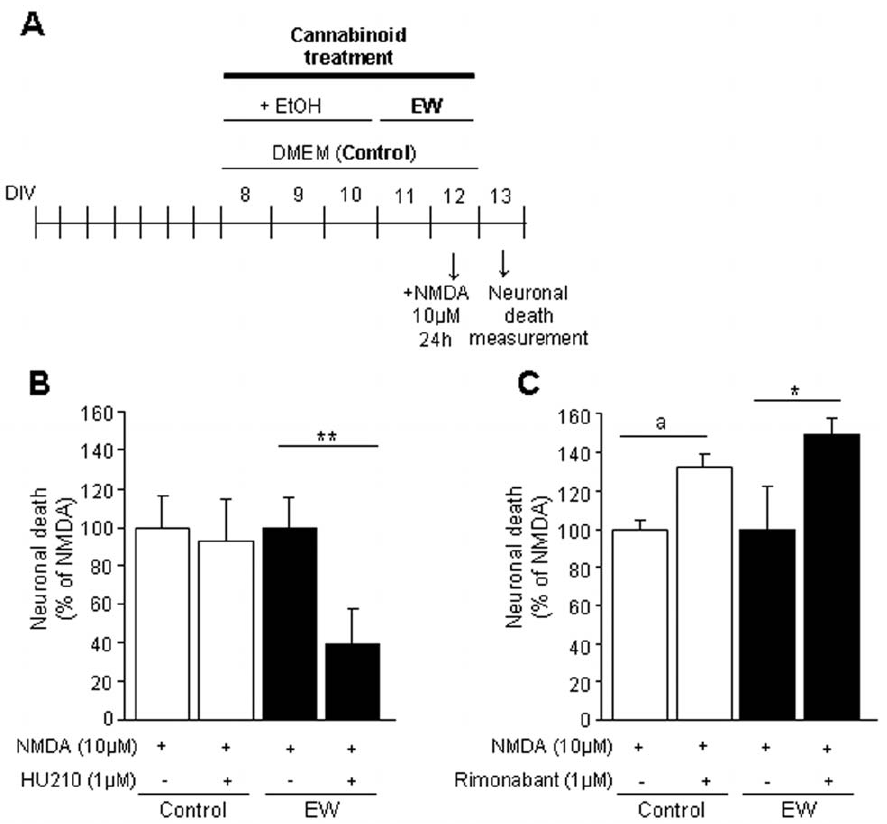
Figure 4. The chronic manipulation of the endocannabinoid system influences neuronal viability during ethanol withdrawal. Effects of the chronic activation or blockade of the endocannabinoid signaling on neuronal viability in control (neurons not exposed to ethanol) or ethanol– withdrawn neurons (EW). (A) Representative scheme of the experimental protocol. (B) The chronic administration of the non-specific cannabinoid agonist HU-210 (1 m M) decreases NMDA-induced neuronal death during ethanol withdrawal. The neuroprotective effect of HU-210 is specific of ethanol withdrawal situation, since it has no effect on the control condition. (C) The chronic administration of the CB1 antagonist rimonabant (1 m M) increases neuronal death. Moreover, the long-term administration of rimonabant tends to be neurotoxic not only for ethanol-withdrawn neurons but also for control neurons. Values are normalized to NMDA and are means 6 SEM (n=6–16 wells/condition; N=3–4 plates). Data were analyzed by the ANOVA test followed by the Fisher’s PLSD test. (* P , 0.05; ** P , 0.01; a,